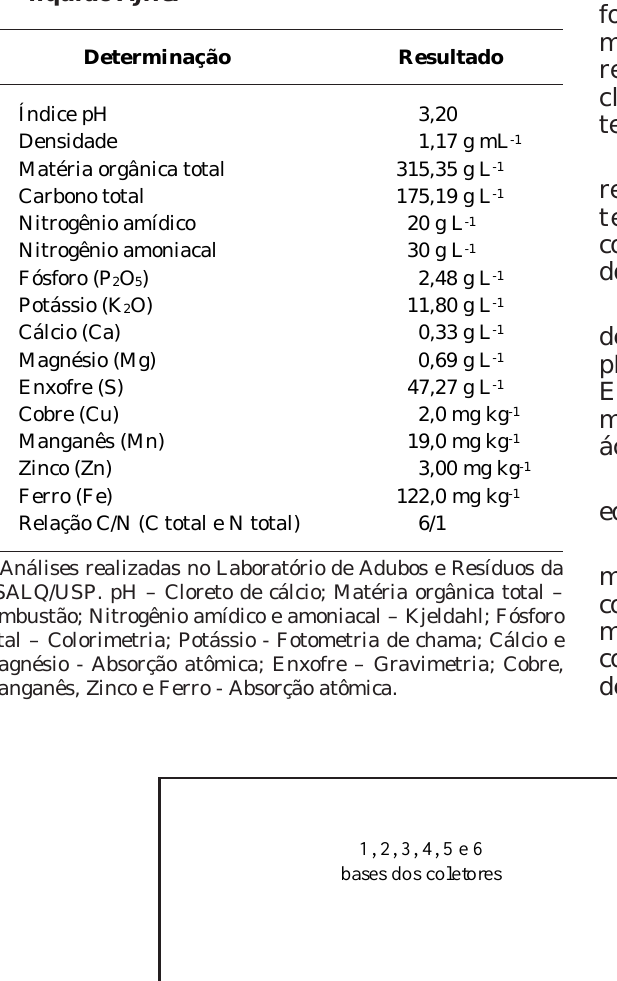
Solo2 3 4 Figura 1. Representação esquemática dos coletores de amônia instalados no campo. (5) Resíduo da produção do glutamato monossódico (GMS) - fabricado pela